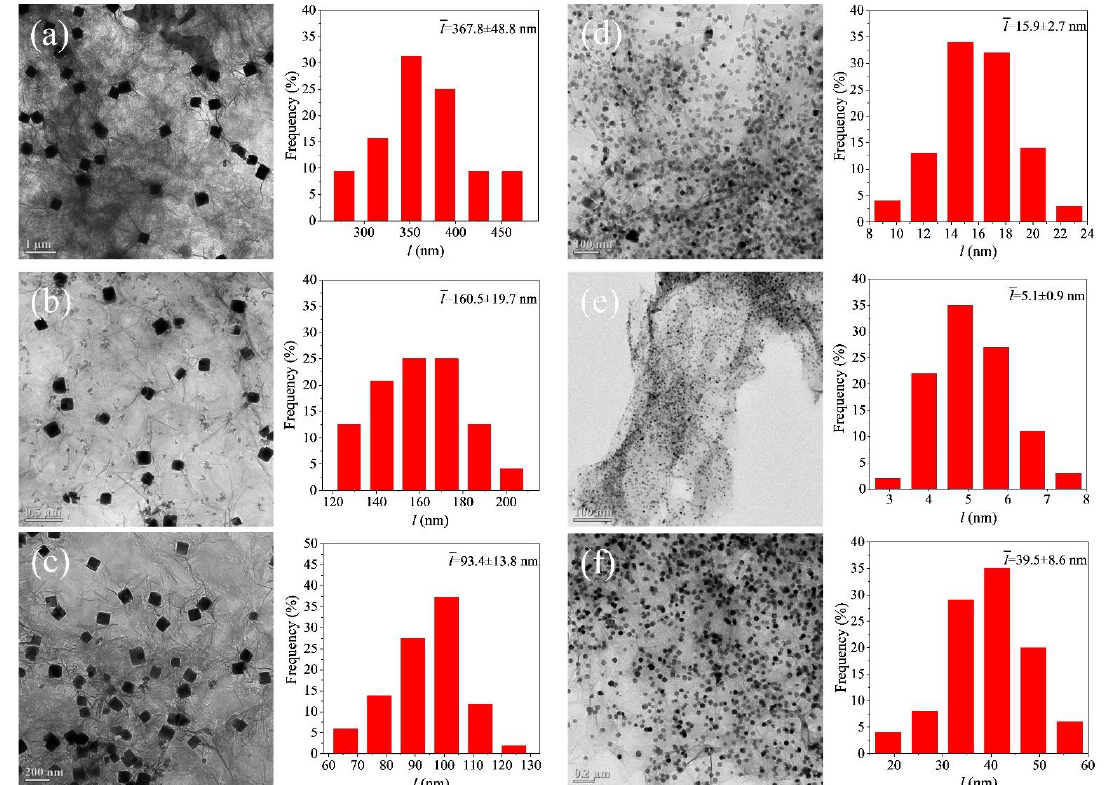
Figure 3. TEM images (left frames) and size histograms (right frames) of the Cu 2 O/rGO composites (i.e., Cu 2 O nanocrystals dispersed on rGO nanosheets) synthesized at different temperatures: ( a ) 220 °C, ( b ) 250 °C, ( c ) 280 °C, ( d ) 300 °C, ( e ) 330 °C, and ( f ) 350 °C. The corresponding products are labeled as ( a ) Cu 2 O/rGO-220, ( b ) Cu 2 O/rGO-250, ( c ) Cu 2 O/rGO-280, ( d ) Cu 2 O/rGO-300, ( e ) Cu 2 O/rGO-330, and ( f ) Cu 2 O/rGO-350, respectively. The statistical histograms of size distributions of the major nanocrystals were determined by analyzing the edge lengths ( l ) of 200 randomly selected nanoparticles. Note: The dominating nanocrystals in the Cu 2 O/rGO-350 sample shown in ( f ) were Cu, even though the sample label was still “Cu 2 O” to show the consistency with the samples synthesized at different temperatures.